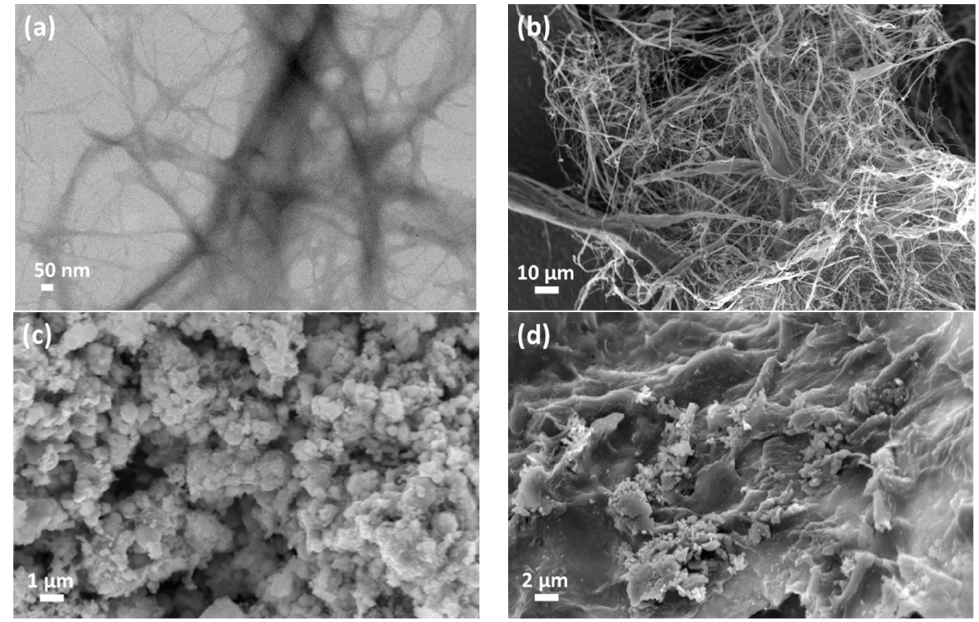
Figure 1. Morphology of ( a ) CNF on TEM and ( b ) CNF, ( c ) Fe(0), and ( d ) functionalized CNF with Fe(0) under the micrograph of FESEM.